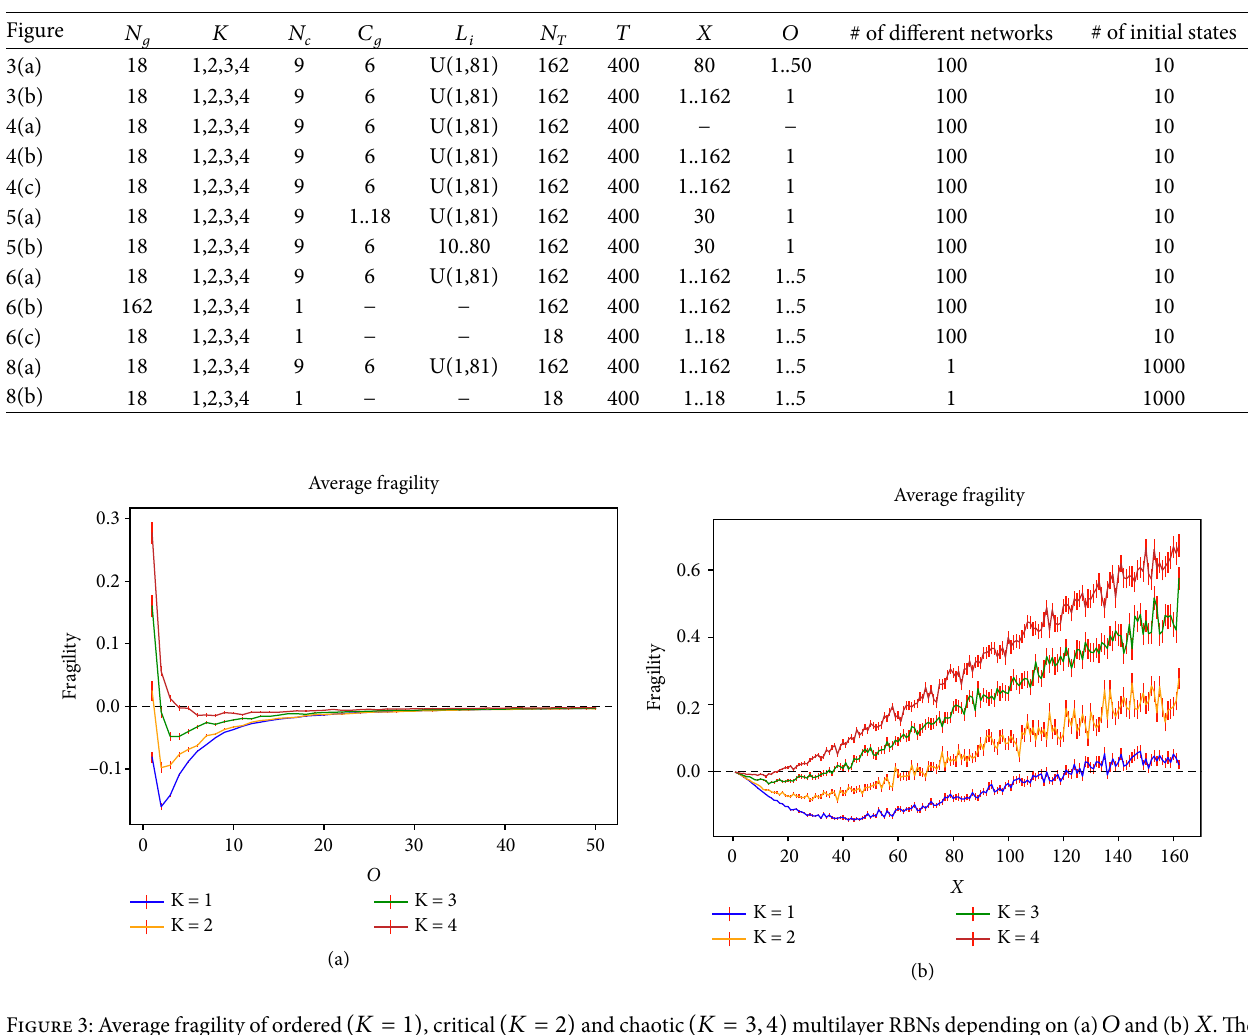
Figure 3: Average fragility of ordered (𝐾 = 1) , critical (𝐾 = 2) and chaotic (𝐾 = 3, 4) multilayer RBNs depending on (a) 𝑂 and (b) 𝑋 . The error bars represent the standard errors of measurements. For each 𝐾 , 100 different networks were used. For each network, 10 initial states , 𝑇 = 400 , and 𝑋 = 80 . (b) 𝑁 , 𝑇 = 400 , and 𝑂 = 1 were randomly chosen. (a) 𝑁 𝑇 = 162 𝑇 = 162